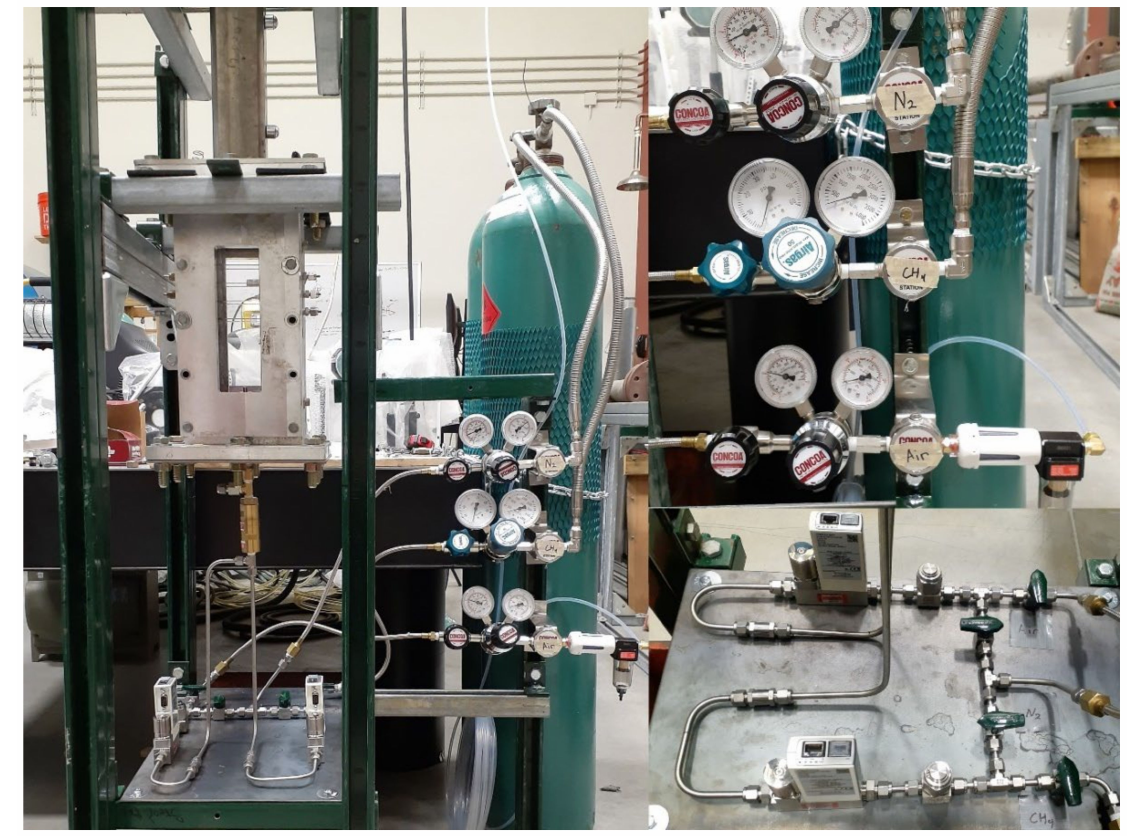
Figure 3. Photographs of the experimental